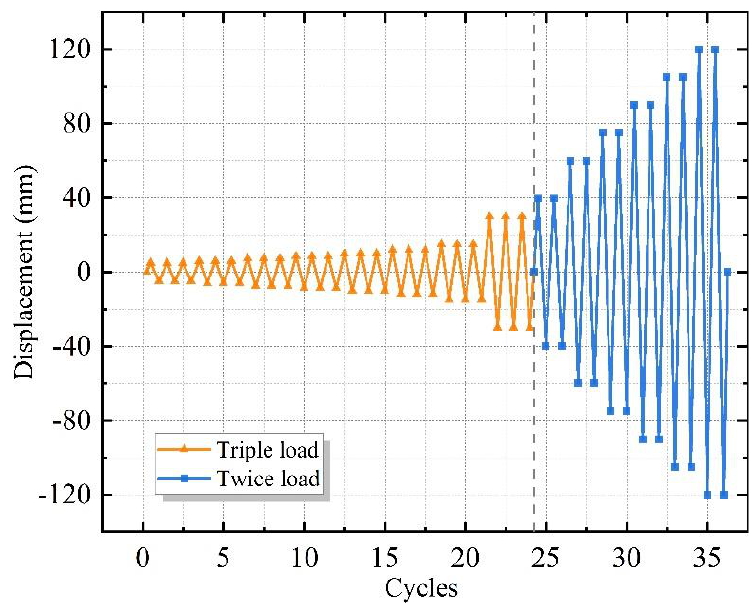
Figure 5. Test loading system.